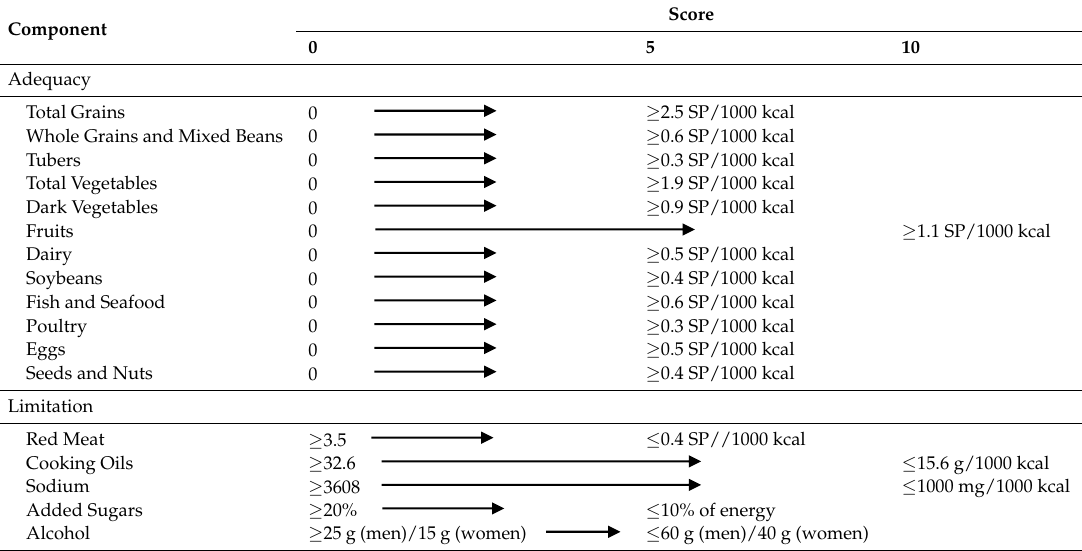
Table 3. Chinese Healthy Eating Index (CHEI) components and standard for scoring.